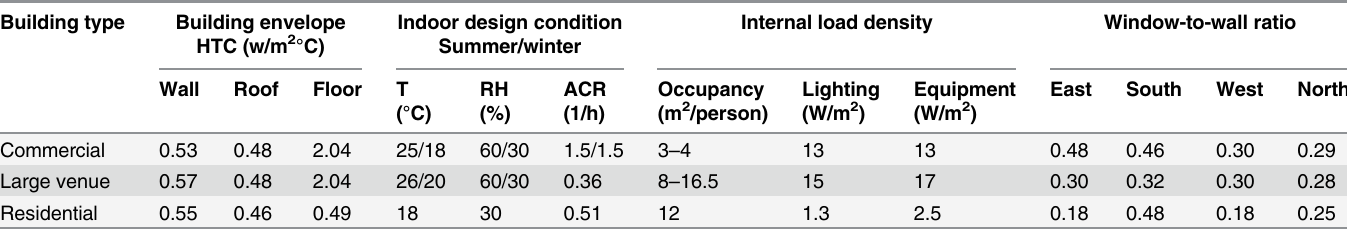
Table 1. Design data for the selected commercial, large venue and residential